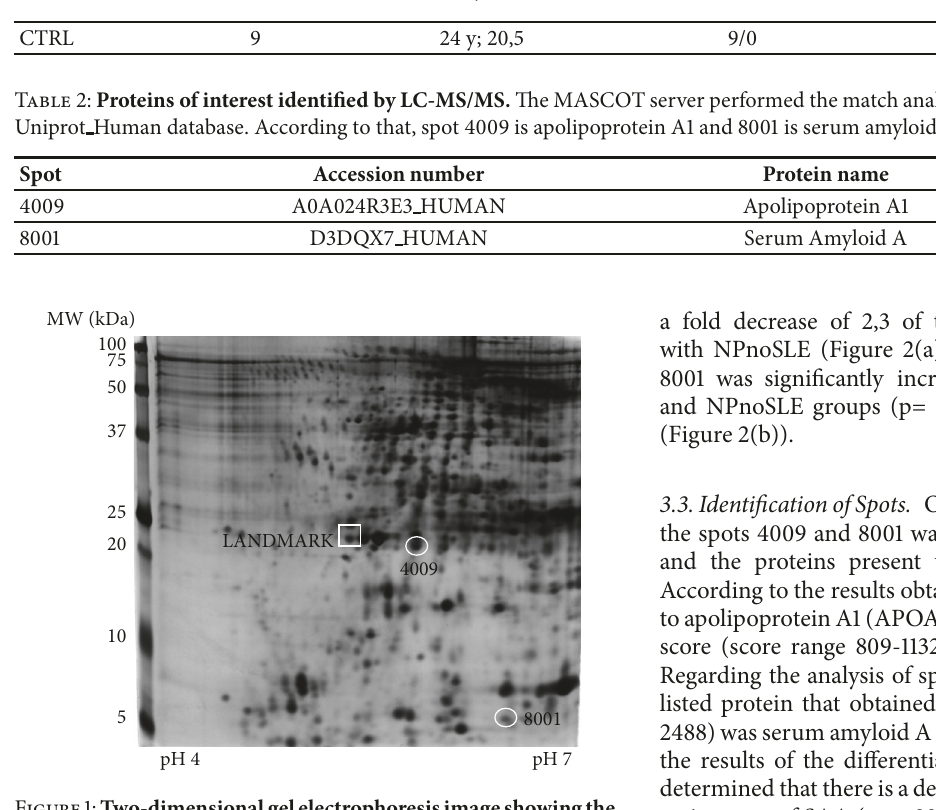
Figure1: Two-dimensionalgelelectrophoresisimageshowingthe twoprotein spots that wereconsistentlyincreasedor decreasedin NPSLEpatientscomparedtotheothergroups. The encircledspots resulted differentially expressed in the high abundance fraction. The calculated molecular weights (MW) and isoelectric points for spot 4009 were 20,9 kDa and pH = 5,9, respectively and for spot 8001 were 6,1 kDa and pH =6,5. The square shows the landmark used for matching 2D images for the comparative analysis. MW: molecular weight in